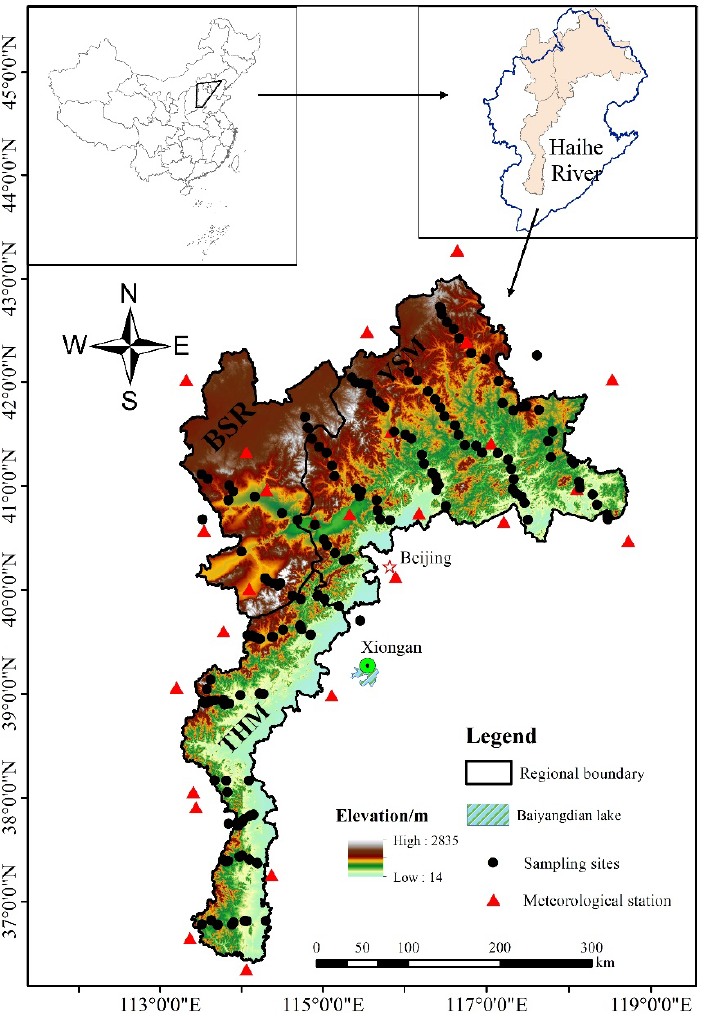
Figure 1. Location of study area (THM—Taihang Mountain, BSR—Bashang region, YSM—Yanshan Mountain).